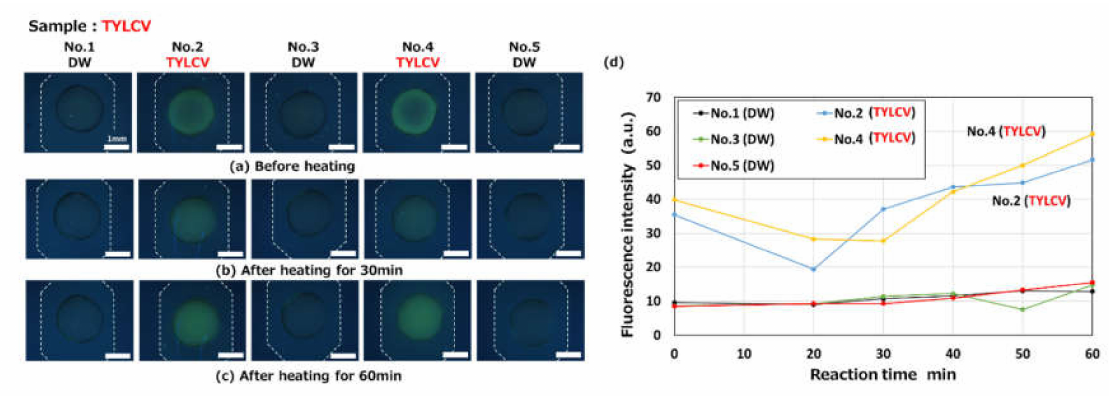
Figure 14. Fluorescence microscopy images showing the LAMP detection of a DNA-based plant virus (tomato yellow leaf curl virus, TYLCV) observed ( a ) before heating and after heating for ( b ) 30 min and ( c ) 60 min at 63 ◦ C (taken with an optical filter BV-2A, gain: 1 × , exposure time: 2 s). A primer set for the detection of TYLCV was pre-spotted in reaction chambers (Nos. 2 and 4). ( d ) Changes in fluorescence intensities as a function of the reaction